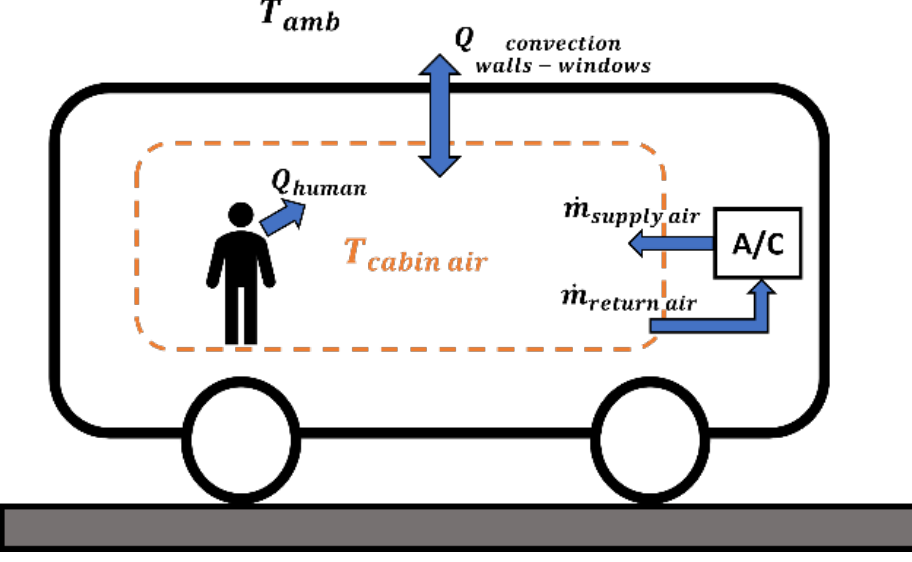
Figure 14. Bus cabin model.